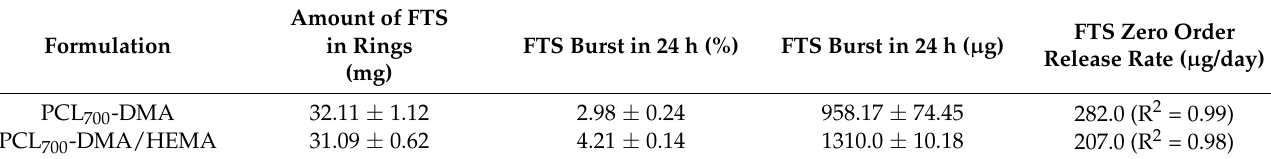
Table 3. Total amount of FTS in rings normalized to the weights of rings (n = 3), release rate of FTS at zero order kinetics ( µ g/day). Amount of FTS Formulation in Rings FTS Burst in 24 h (%) FTS Burst in 24 h ( µ g) (mg) PCL 700 -DMA PCL 700